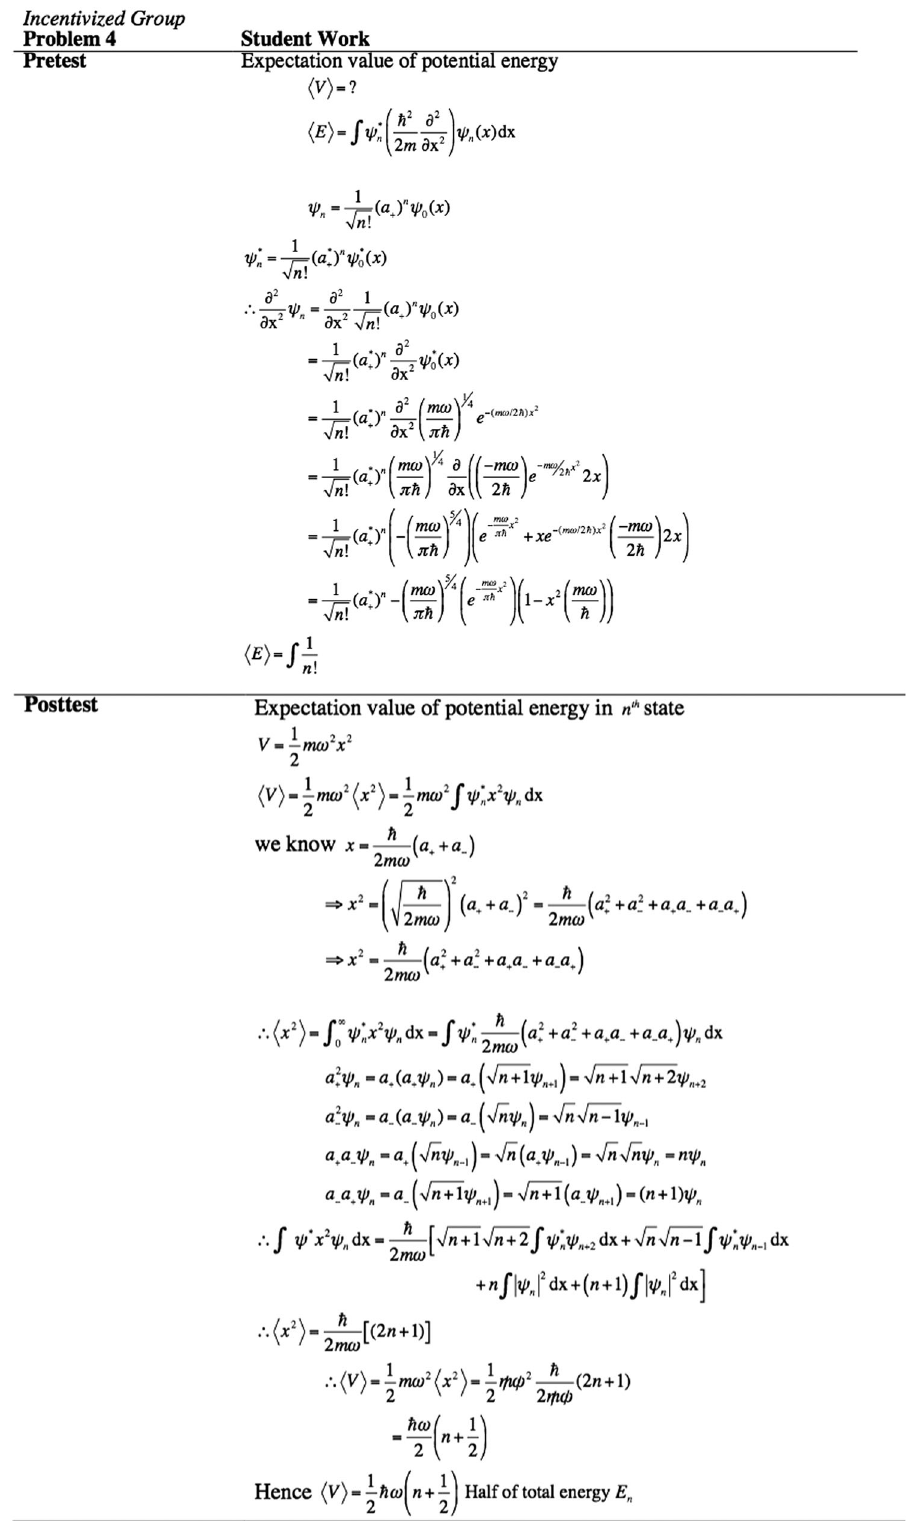
FIG. 10. An example of a pretest and posttest solution pair for a student from the incentivized group which demonstrates improvement in student understanding for the harmonic oscillator problem. The pretest and posttest scores are 33% and 100% for invoking, 0% and 100% for applying, and 17% and 100% for the overall scores, respectively. The pretest shows that the student struggles and eventually abandons the problem, but in the posttest, the student demonstrates proficient use of the ladder operators to solve the